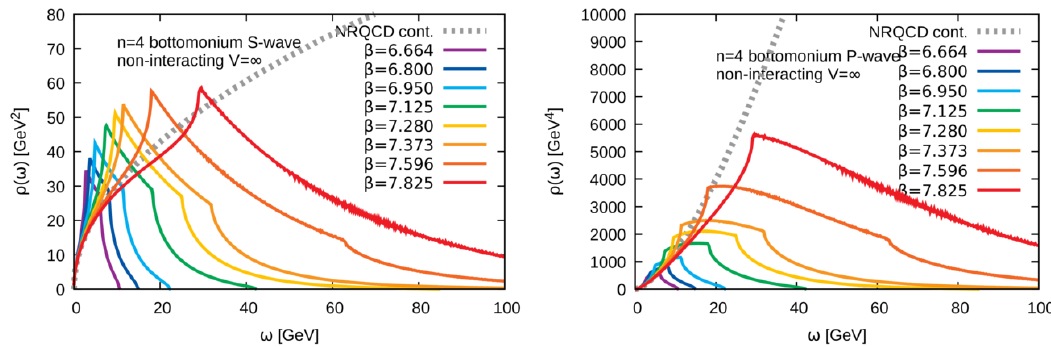
Figure 26 . A selection of Lattice NRQCD bottomonium spectral function in the absence of interactions in the thermodynamic limit at Lepage parameter n = 4. The S-wave channel is shown on the left, the P-wave channel on the right.The curves correspond to a representative selection of the values of a s M b labeled by the corresponding (cid:12) values of the HotQCD